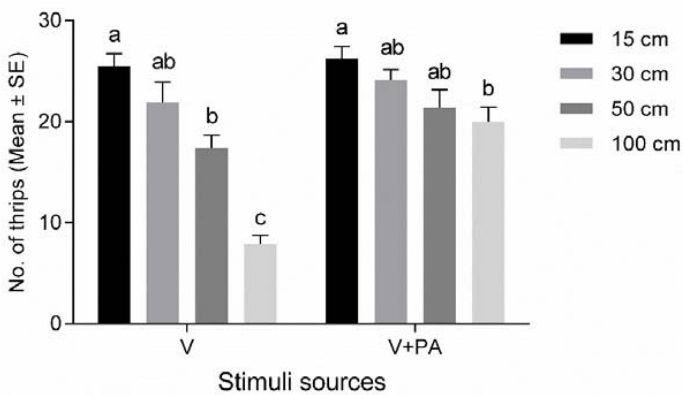
Figure 3. Choice of cues by western flower thrips, Frankliniella occidentalis at di ff erent distances. Yellow sticky card (visual cue, V) and p -anisaldehyde (PA) sprayed to yellow sticky card (V + PA) used in luring thrips at di ff erent distances. Di ff erent letters of the same stimulus mean orientation e ffi cacy di ff ered between distances (Tukey’s HSD test, p < 0.05).